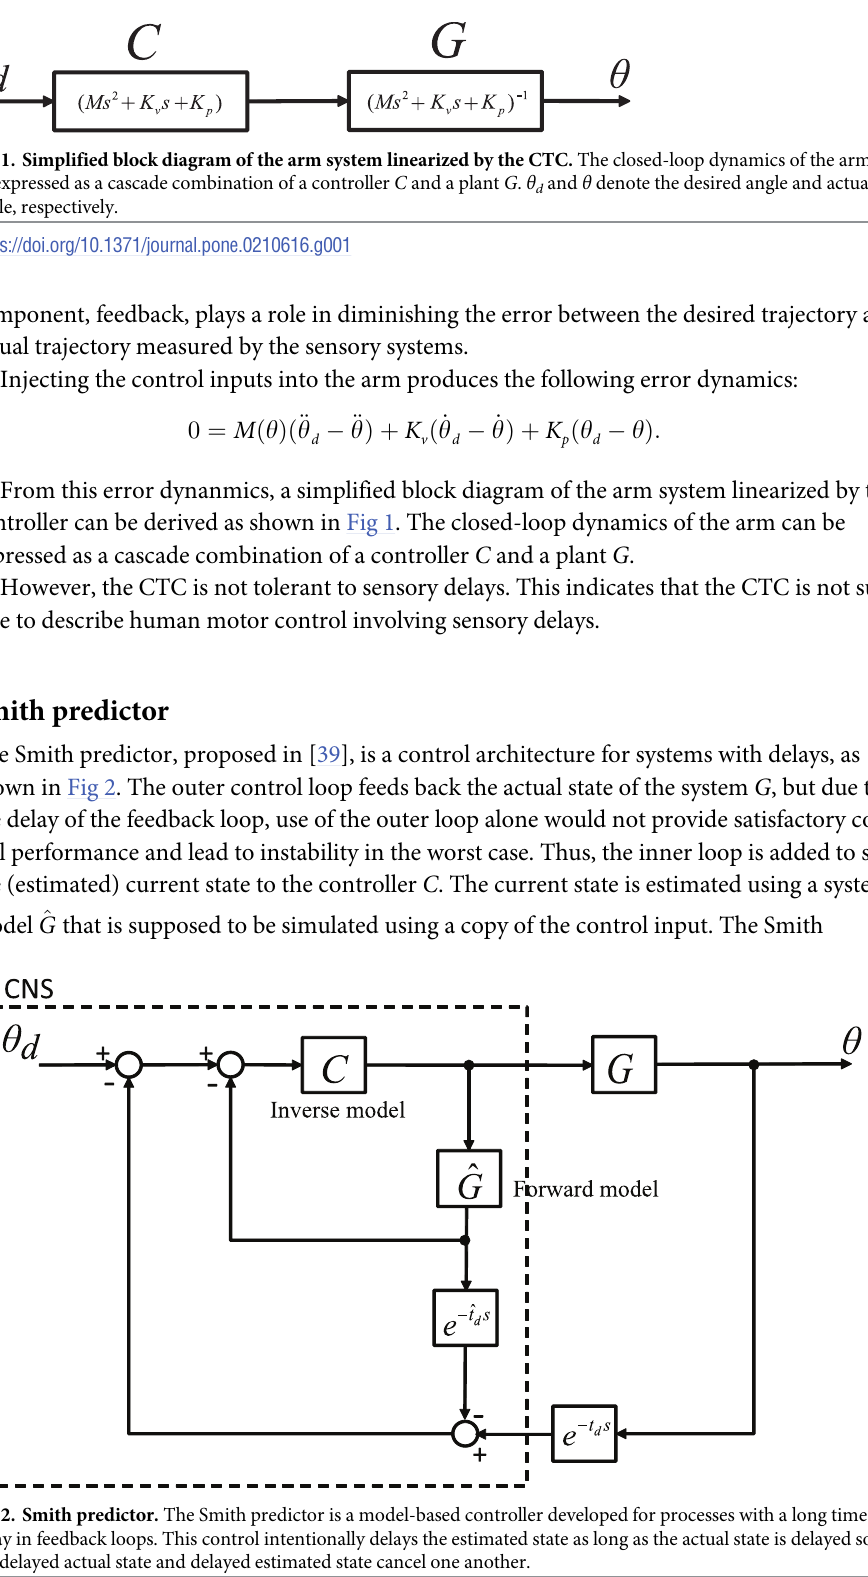
and θ denote the desired angle and actual d